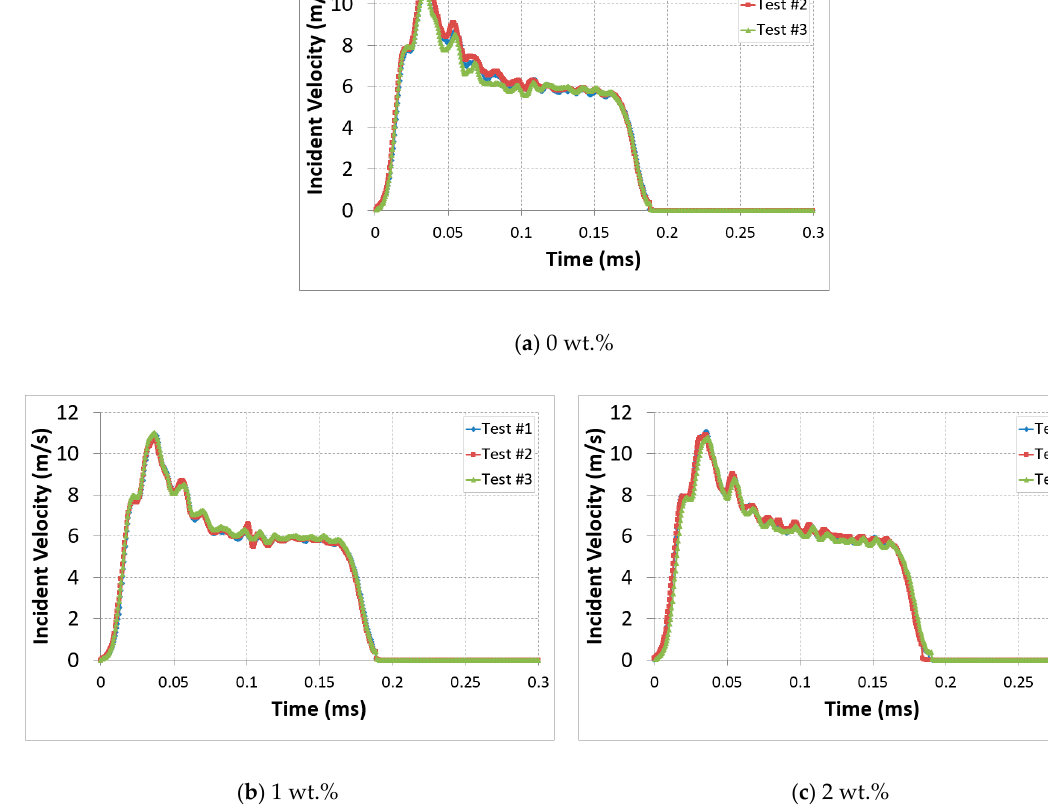
Figure 7. Test reproducibility of the nanocomposites with di ff erent CNTs mass fractions, P = 4 bar.